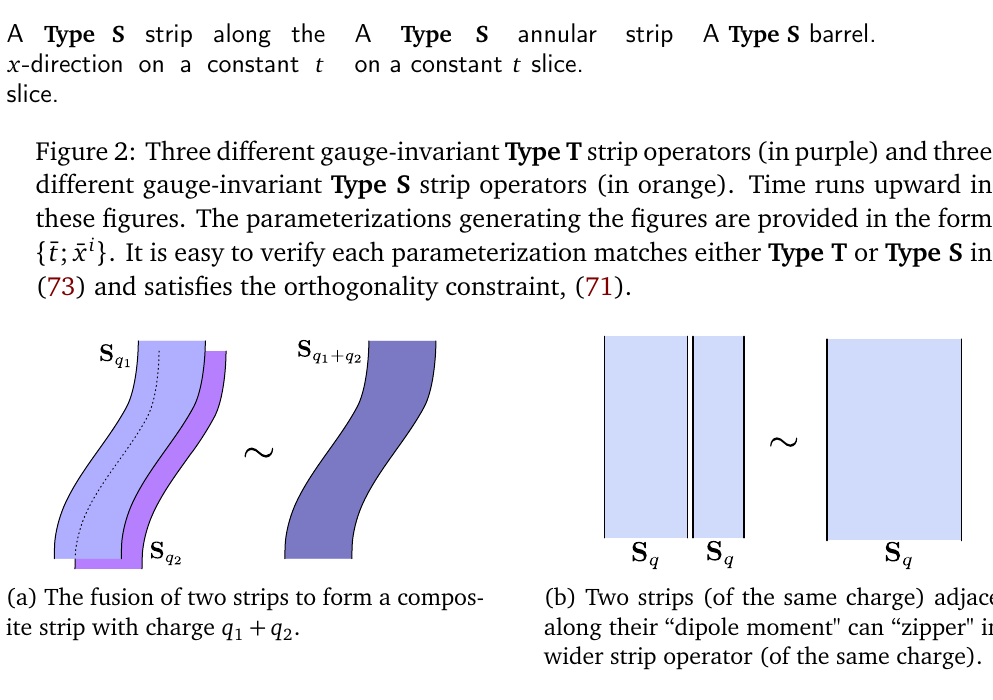
Figure 3: Two possible ways strip operators can form a composite strip